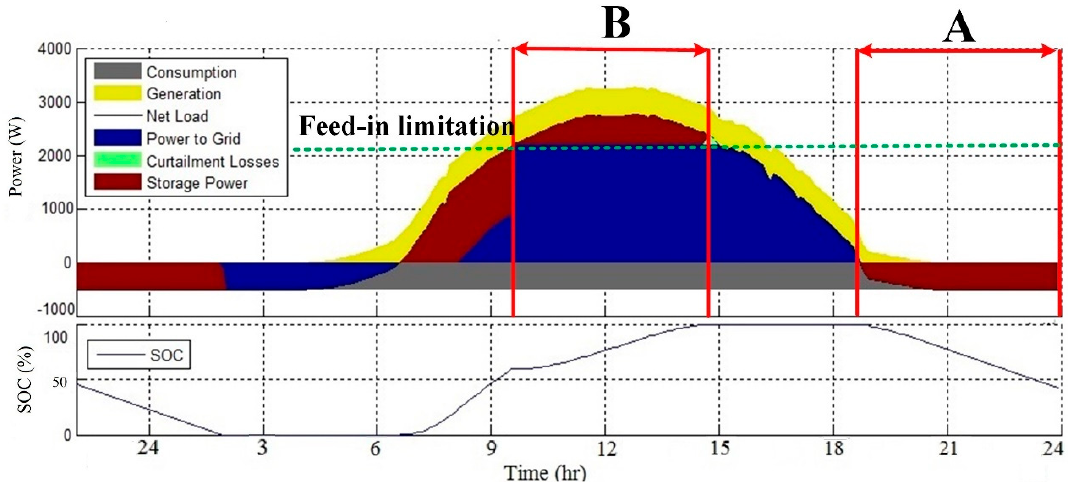
Figure 9. The simulated results of power profiles for an example day.